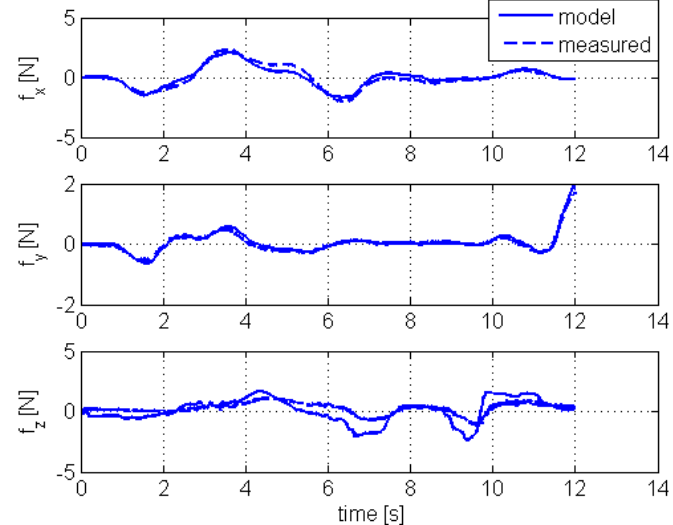
Figure 12. Results of experiment no. 3: forces in x , y , z ∈ EF coordinates for Falcon V5 real UAV (measured) and its